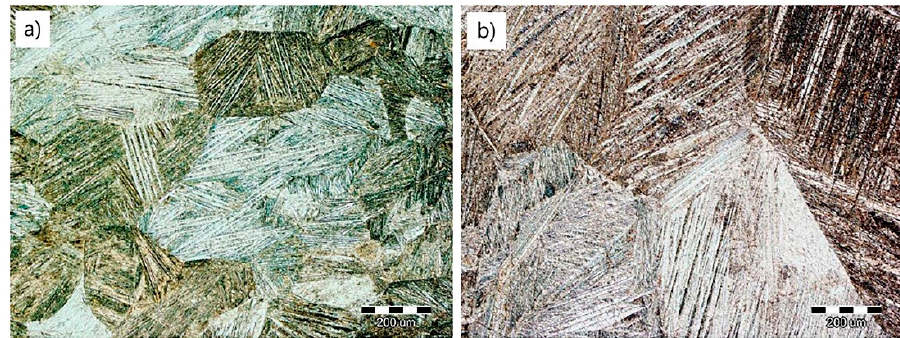
Figure 1. Optical micrographs of CuAlNi shape memory alloy in the as-cast state ( a ) and after solution annealing at 885 °C/60 min H 2 O ( b ).